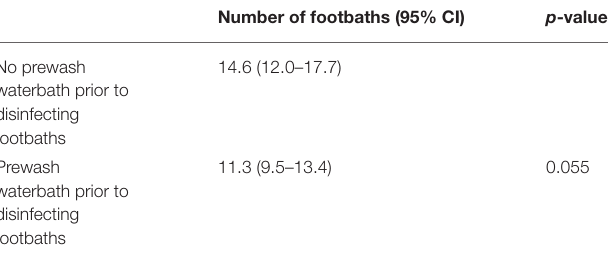
TABLE 4 | Mean numbers of footbaths required for complete elimination of virulent strains of D. nodosus at flock level with and without a prewash